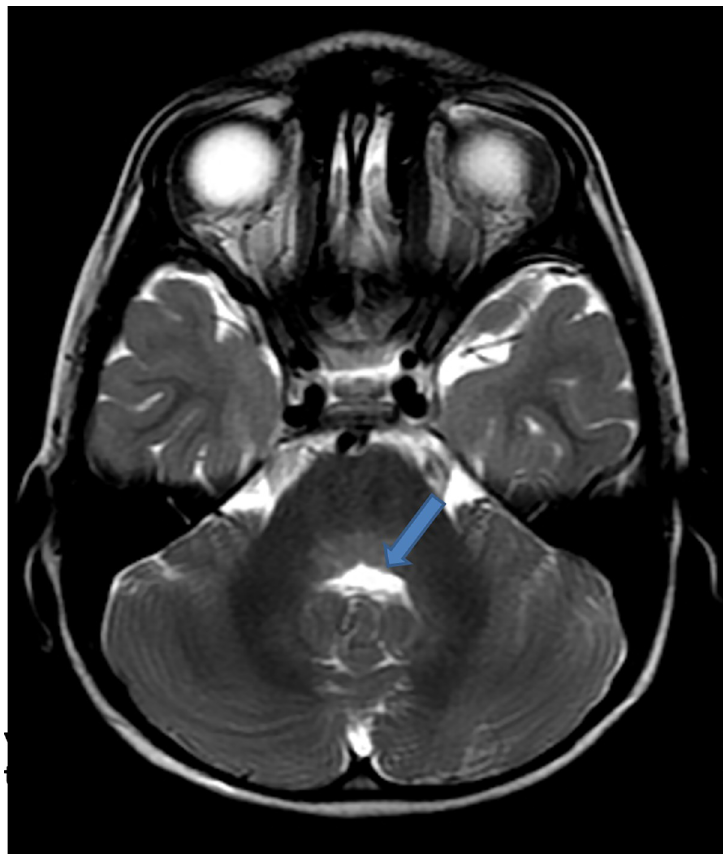
Fig 3. T2 hyperintensities noted in posterior 1/3 of pons. Pontomedullary junction, medulla oblongata, and posterior part of left temporal